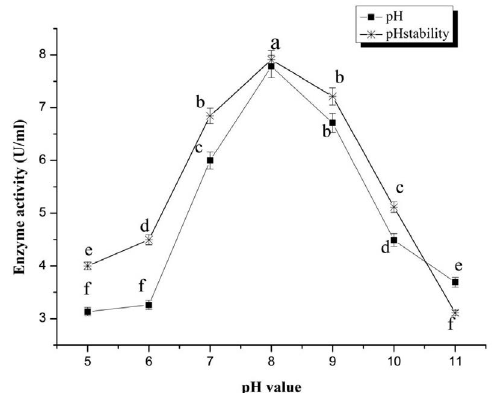
Fig. 2. Effect of pH and pH stability on the activity of purified SSF